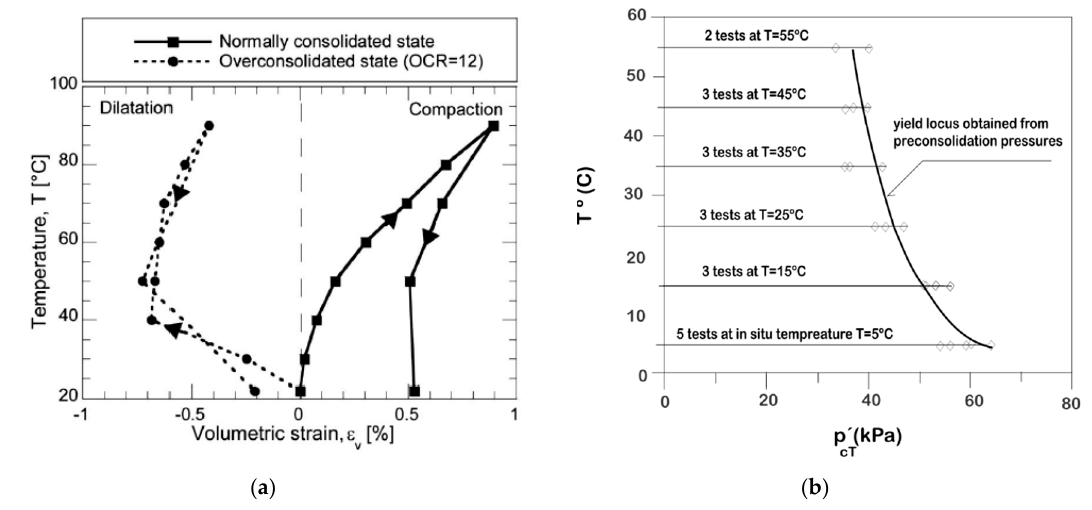
Figure 5. ( a ) Temperature vs. volumetric strain [157,158]; ( b ) Temperature vs. pre-consolidation pressure [160]. pressure